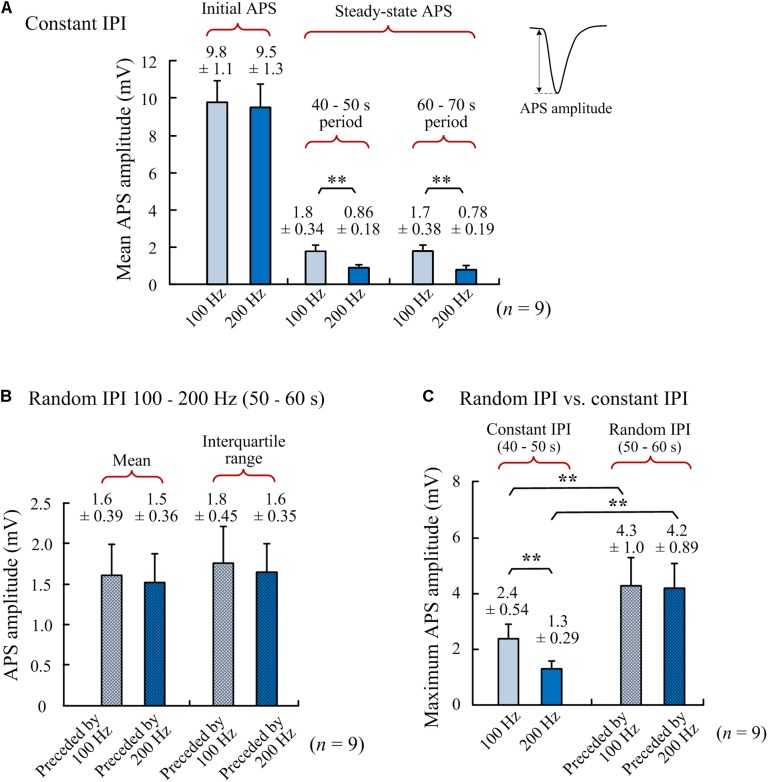
Comparisons of APS amplitudes among different periods of A-HFS. (A) Amplitudes of the initial APS (evoked by the very first pulse at the onset of A-HFS) and the steady-state APS (mean amplitudes in 40–50 s and 60–70 s of stimulations) during A-HFS with constant IPI 100 and 200 Hz, respectively. (B) Mean APS amplitudes and interquartile ranges of APS amplitudes during 10-s A-HFS periods (50–60 s) with random IPI (100–200 Hz) preceded by 100- or 200-Hz constant stimulations, respectively. (C) Maximum APS amplitudes during A-HFS periods with constant IPI (steady-state) and with random IPI. ∗∗P < 0.01, n = 9, t-test.